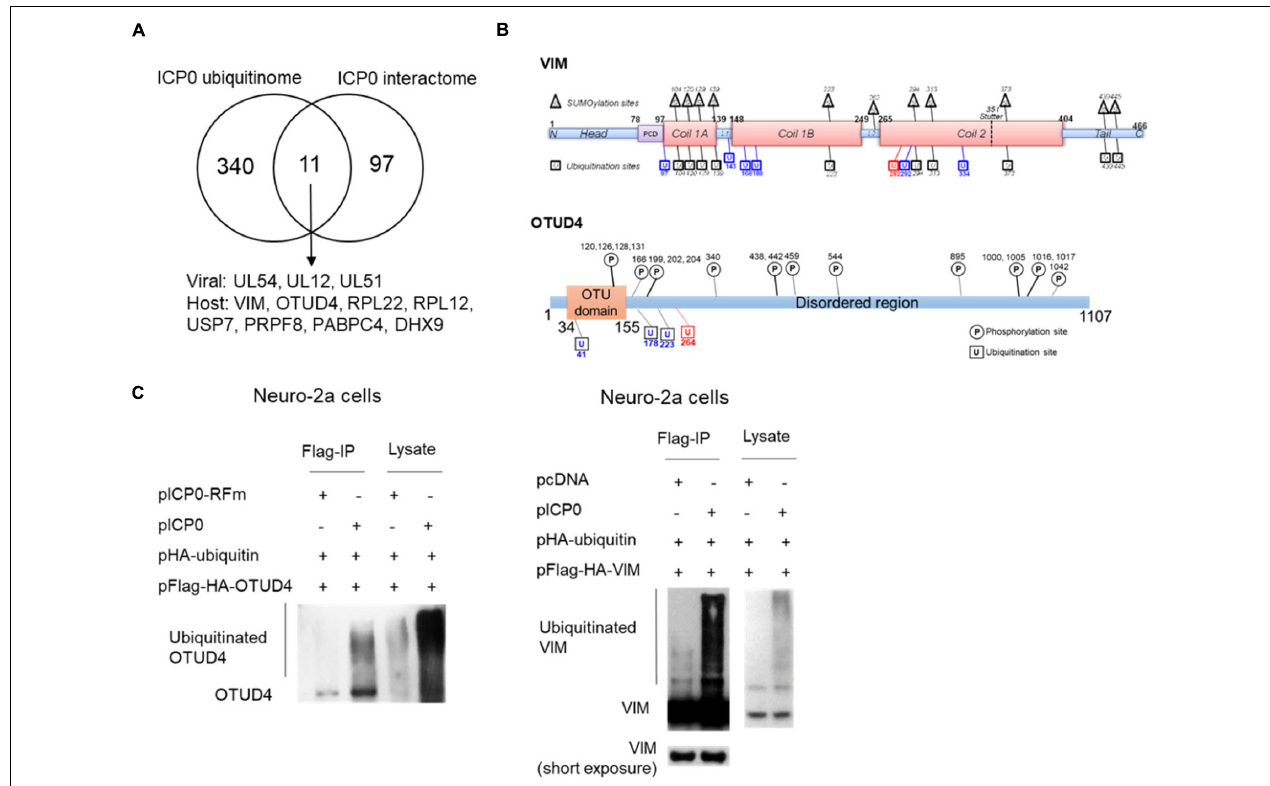
FIGURE 5 | ICP0-mediated ubiquitination of OTUD4 and VIM. (A) Venn diagram showing 12 proteins identified by both ICP0 interactome and ubiquitinome analyses. (B) Summary of ubiquitination sites on VIM (upper) and OTUD4 (lower). Schematic representation of functional domains of VIM and OTUD4 decorated with previously documented SUMOylation (for VIM, in triangles) or phosphorylation (for OTUD4, in circles) sites and newly identified ubiquitination sites (in squares). L, linker region; PCD, pre-coiled domain. Blue indicates sites with ubiquitination but not SUMOylation. Red indicates the ubiquitination site potentially targeted by ICP0. (C) Neuro-2a cells in each 100-mm plate were co-transfected with 5 µ g of a plasmid expressing Flag-HA-tagged OTUD4 (left) or VIM (right), 2 µ g of a plasmid expressing HA-tagged ubiquitin, and 3 µ g of a plasmid expressing ICP0 or its RING finger mutant (RFm) or an empty vector (pcDNA) for 48 h. Cell lysates were immunoprecipitated by an anti-Flag antibody. The lysates and immunoprecipitated samples (IP) were analyzed by Western blots for ubiquitination levels by an anti-HA antibody.